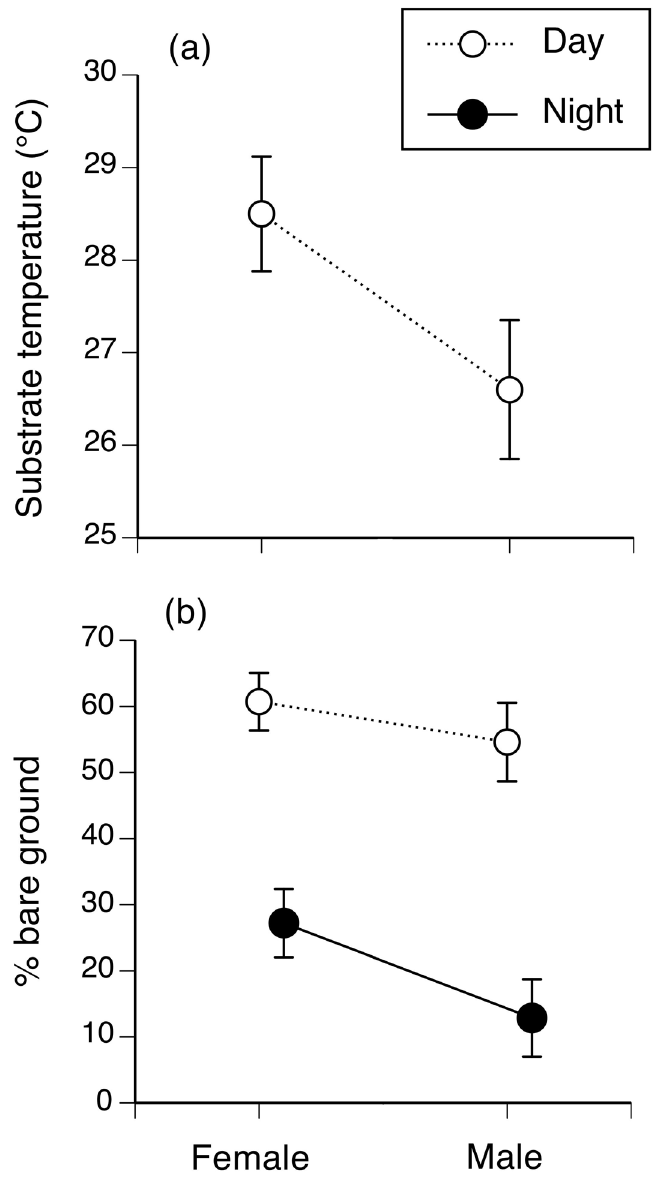
Fig 5. Microhabitat selection as a function of sex. Figure shows microhabitat use of 40 radio-tracked and spool-tracked cane toads on Hawai ’ i. The panels show interactions between time (day vs. night) and toad sex: (a) substrate temperature, as recorded with an infrared thermometer (recorded only by day); and (b) the % of bare ground within a 1-m quadrat surrounding the toad. Figure shows mean values and associated standard